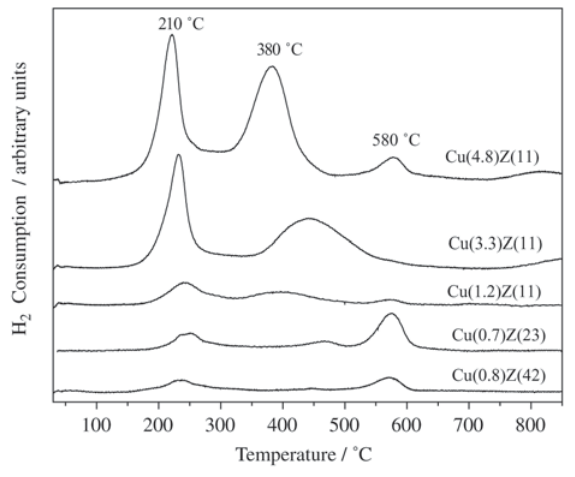
Figure 4. H -TPR profiles of Cu/ZSM-5 2